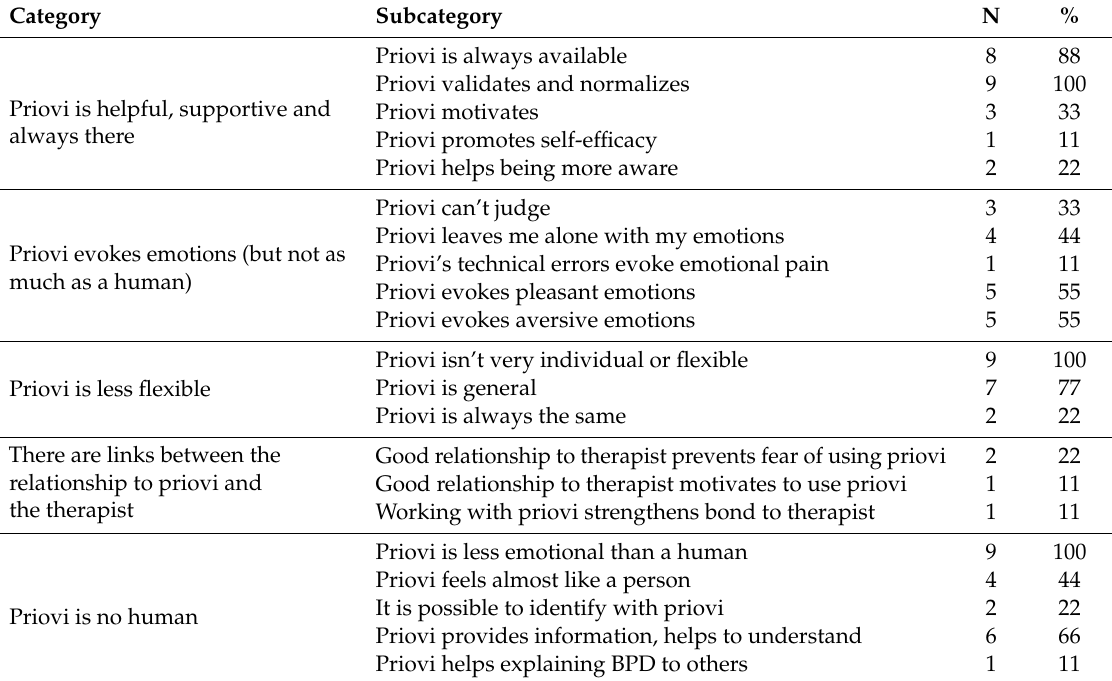
Table 2. Category System: Facets of a relationship to